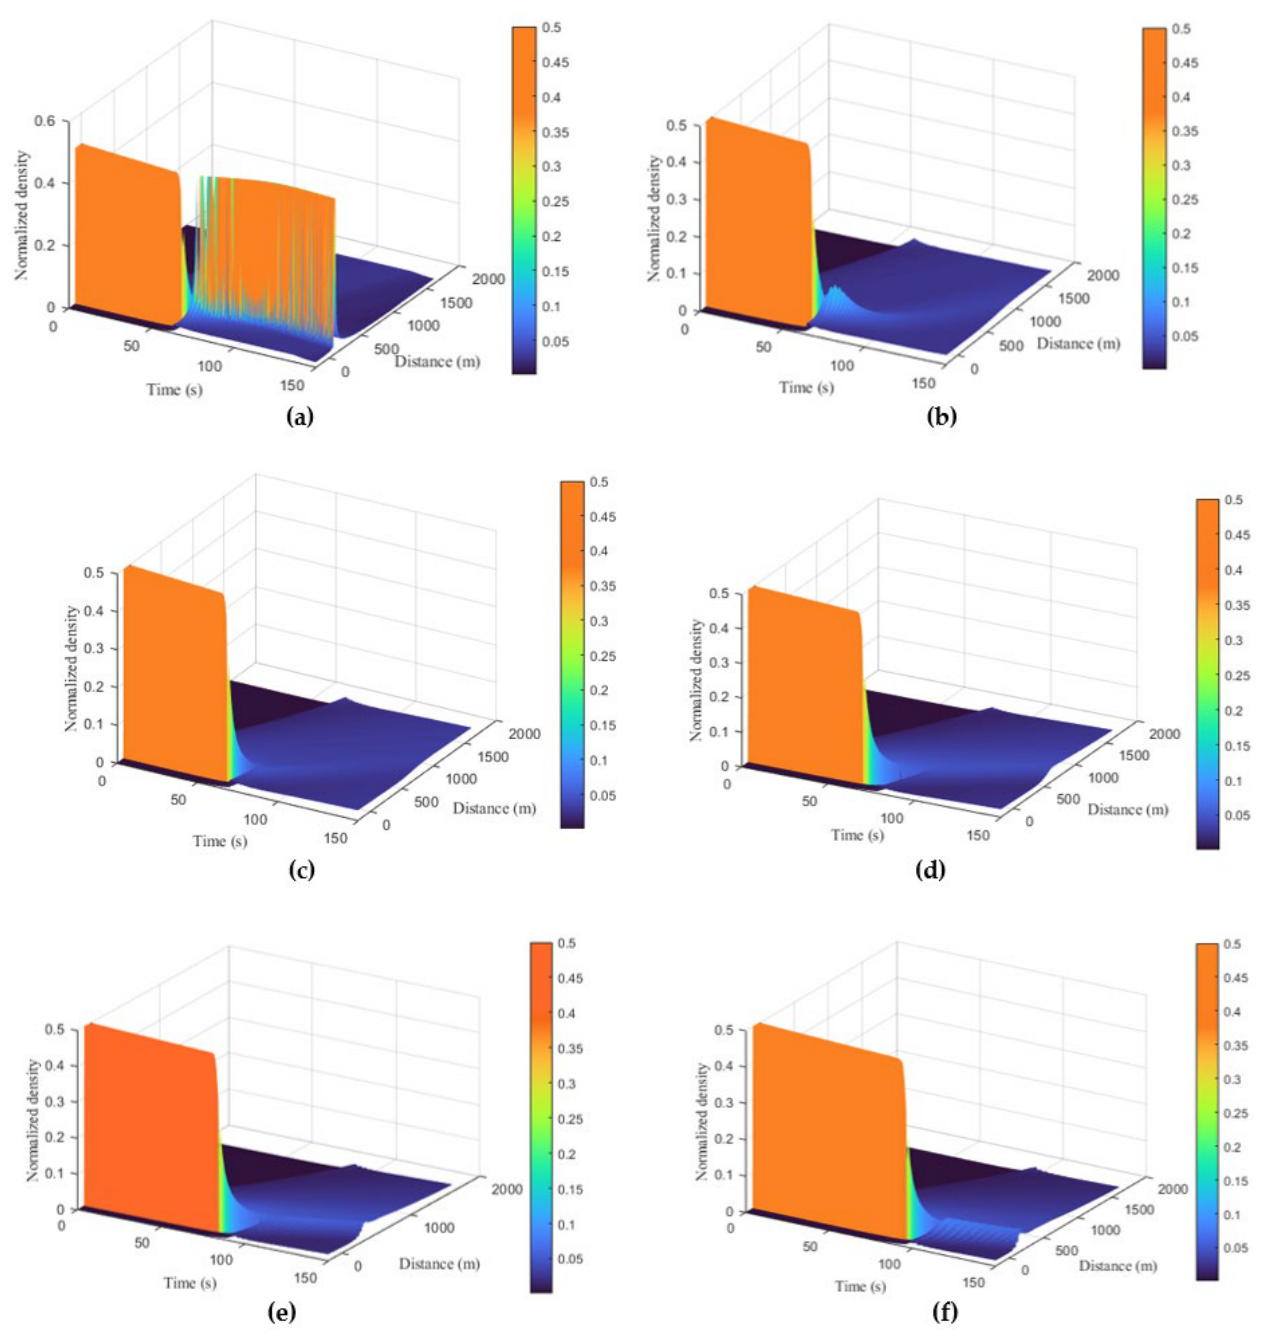
Figure 13. Spatio–temporal density for the proposed model over an 1800 m circular road: ( a ) a = 0.5 m; ( b ) a = 0.6 m; ( c ) a = 1 m; ( d ) a = 1.5 m; ( e ) a = 2 m; ( f ) a = 2.2 Table 10. Density and time for the proposed model during and after the queue dissolves.